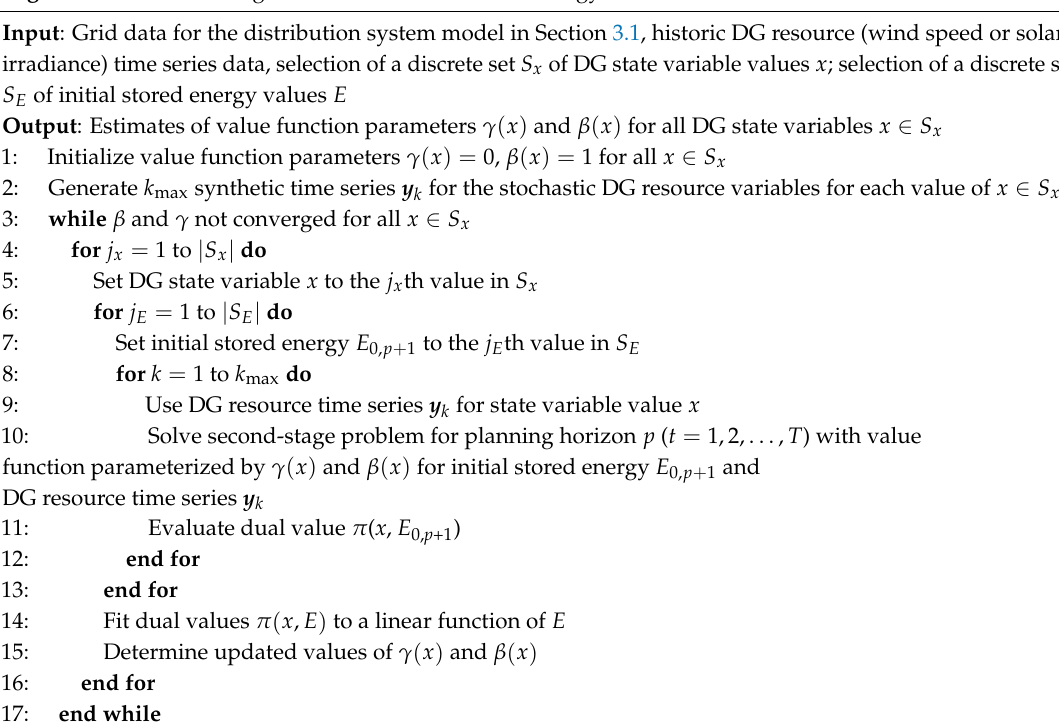
Algorithm 1: Determining Value Function for Stored